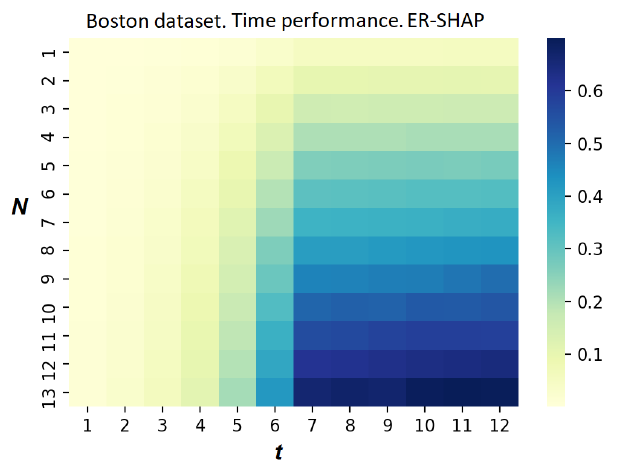
Figure 15. The heatmap reflecting the concordance index C obtained by ER-SHAP for the Boston Housing dataset.